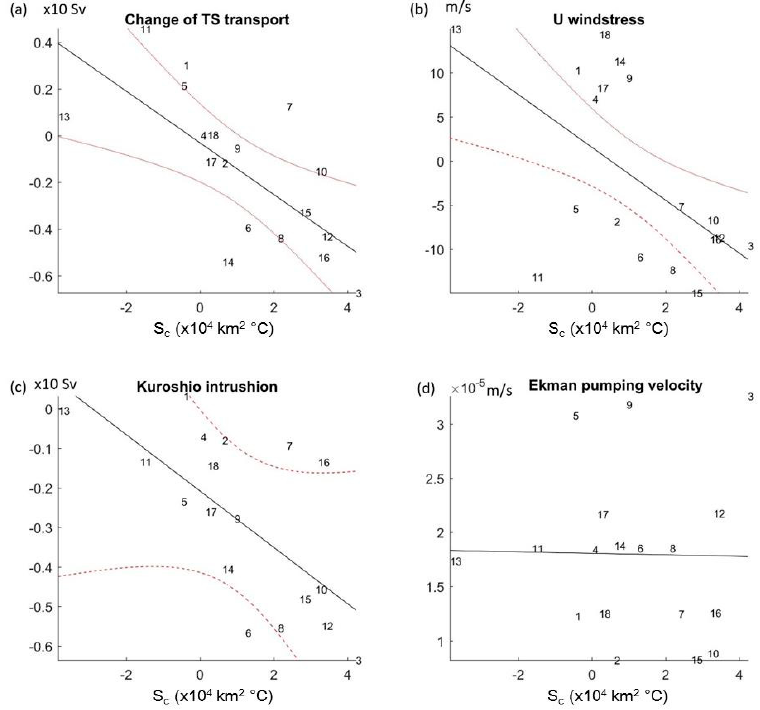
Figure 9. Linear relationship between ( a ) the change in Taiwan Strait transport, ( b ) the Kuroshio intrusion, ( c ) east–west wind stress, ( d ) the Ekman pumping velocity, and S c (×10 4 km 2 °C) (defined in Section 2), respectively. Numbers correspond to the typhoons listed in Figure 2. The red dash-lines show the 95% confidence interval.